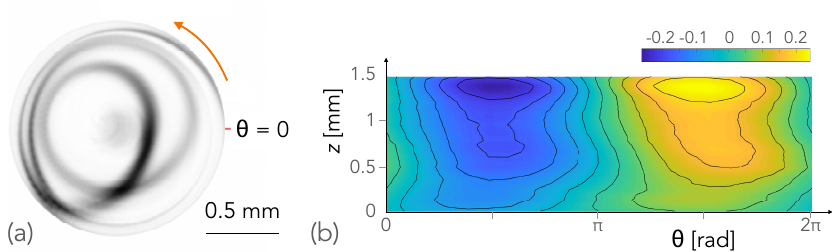
Figure 11. ( a ) Coherent structure in the rotating frame of reference observed through a hot disk and ( b ) temperature-deviation distribution over free surface from a terrestrial experiment with a liquid bridge of Γ = 2.0 ( R = 0.75mm) and V / V 0 = 0.8 under Ma | L = H = 1.86 × 10 4 . The image of ( a ) the coherent structure is drawn by integrating for 10 fundamental periods or 3.8s, and the temperature deviation in ( b ) is obtained by averaging the images for 65 fundamental periods or 24.7s. The arrow in the row ( a ) indicates the direction of the travelling